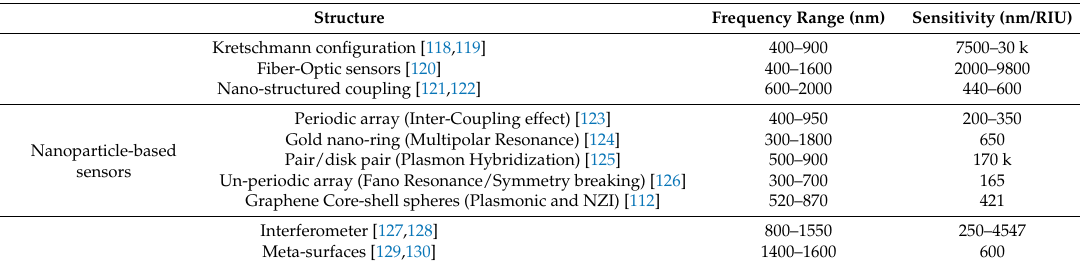
Table 1. Sensitivity (nm/RIU) comparison for different LSPR